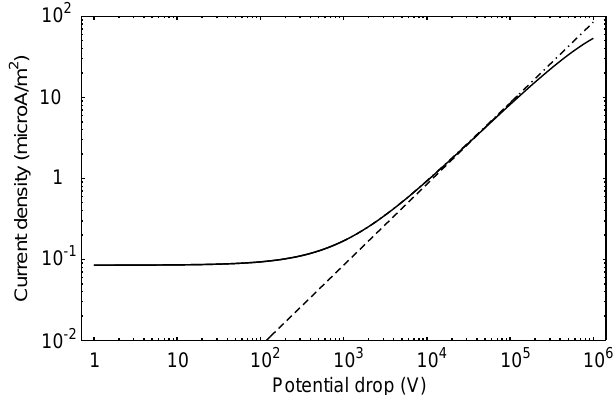
Fig. 1. The exact nonlinear current density ( solid ), the first approximation ( dash ) and the second approximation ( dot ) line for an isotropic Maxwellian distribution for parameters shown in Table 1. The exact and first approximation curves di(cid:128)er only for potential drops larger than about 100kV. The first and second approximations, on the other hand, overlap for potential drops larger than about 30 kV, resulting in a dash-dot